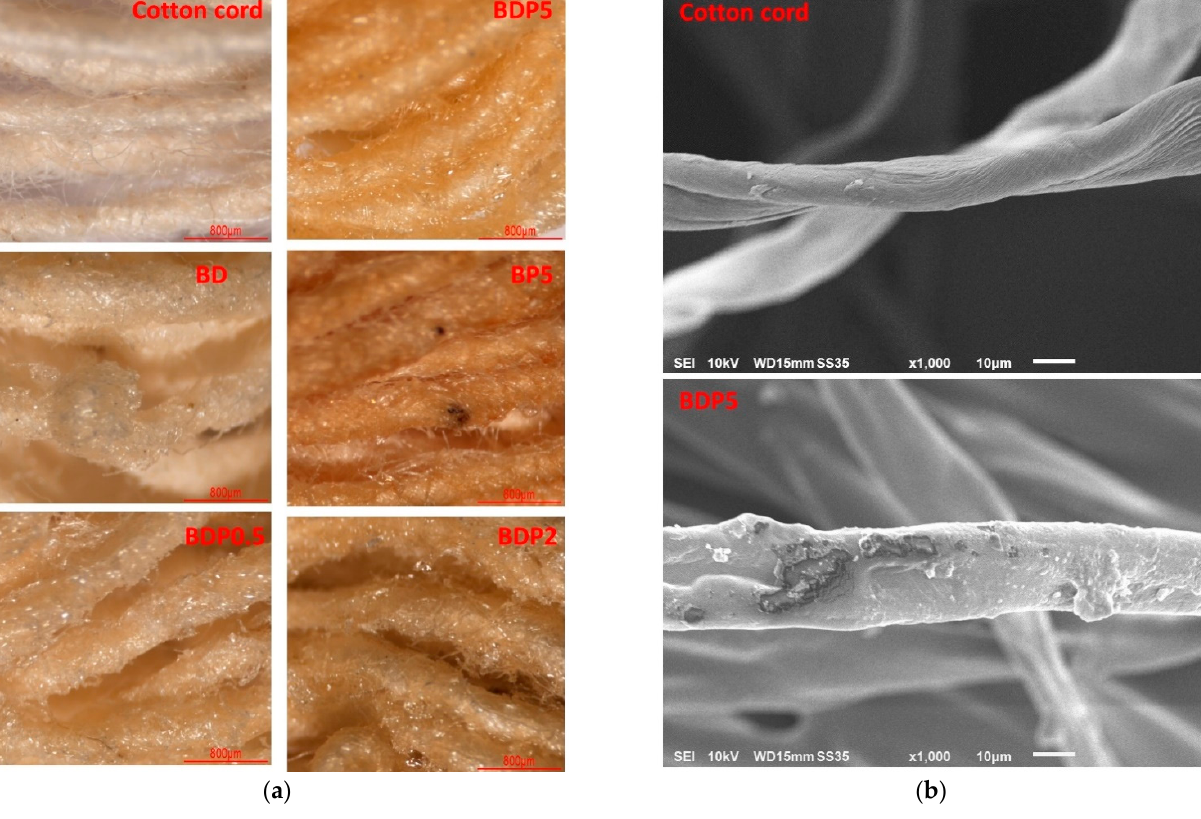
Figure 2. ( a ) Physical appearance of virgin cotton cord, BD, BP5, BDP0.5, BDP2, and BDP5 by stereomicroscope; ( b ) SEM images of virgin cotton cord and BDP5.